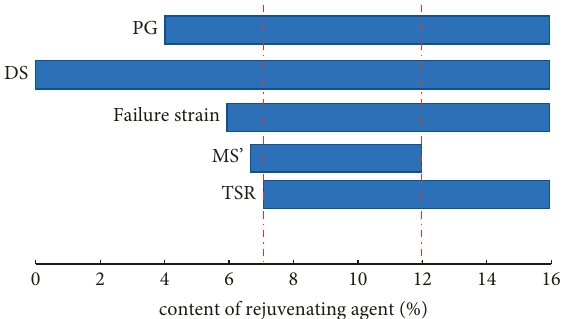
Figure 10: Optimum content of rejuvenating agent (second